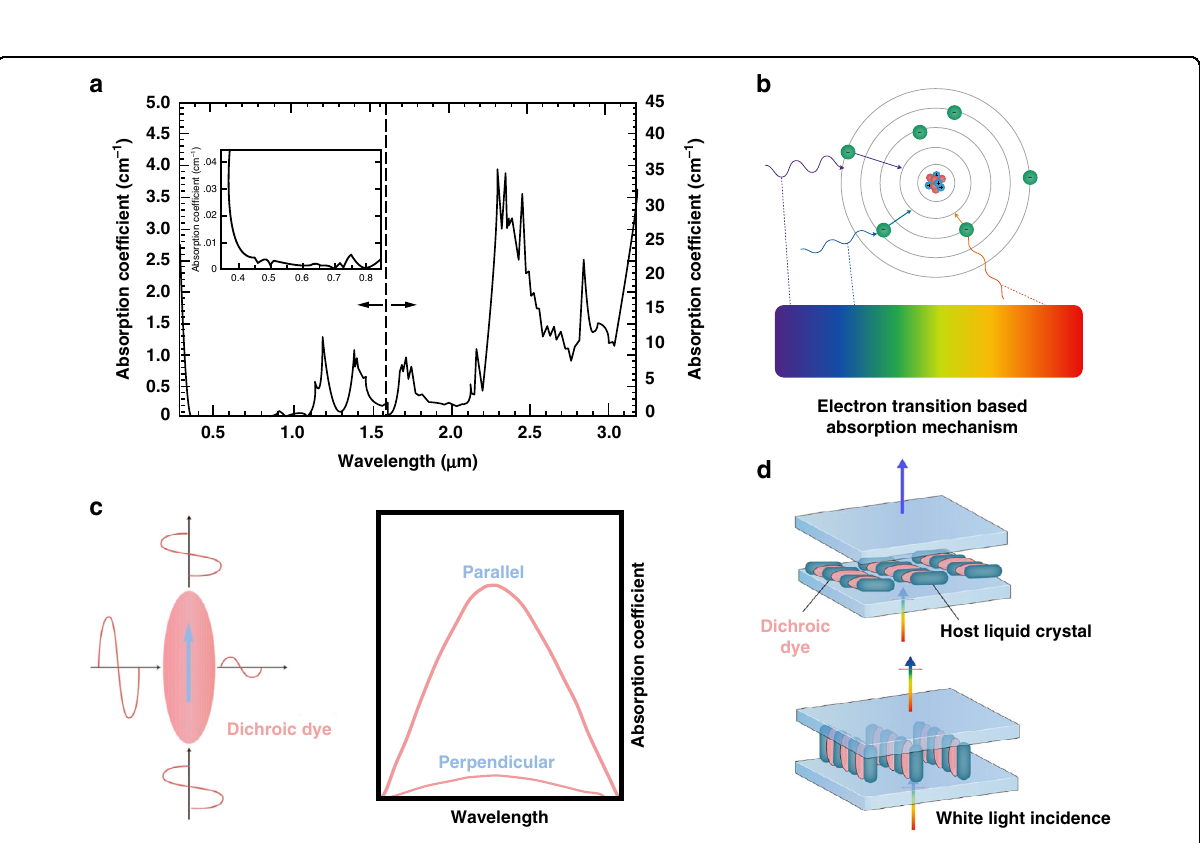
Fig. 5 Absorption based on electron transition. a Absorption spectra of NLC 5CB. Reproduced with permission from ref. 229 . Copyright 1998, AIP Publishing. b Electron transition absorption mechanism of molecules. c Optical properties of positive (p-type) dichroic dyes. d Schematic of the guest-host